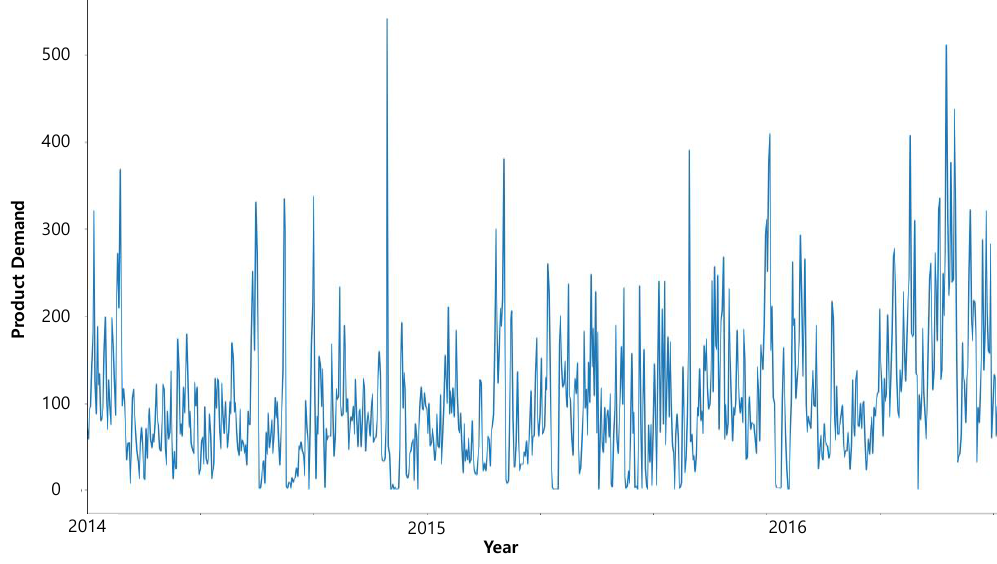
Figure 3. Time-series graph of daily product demand .